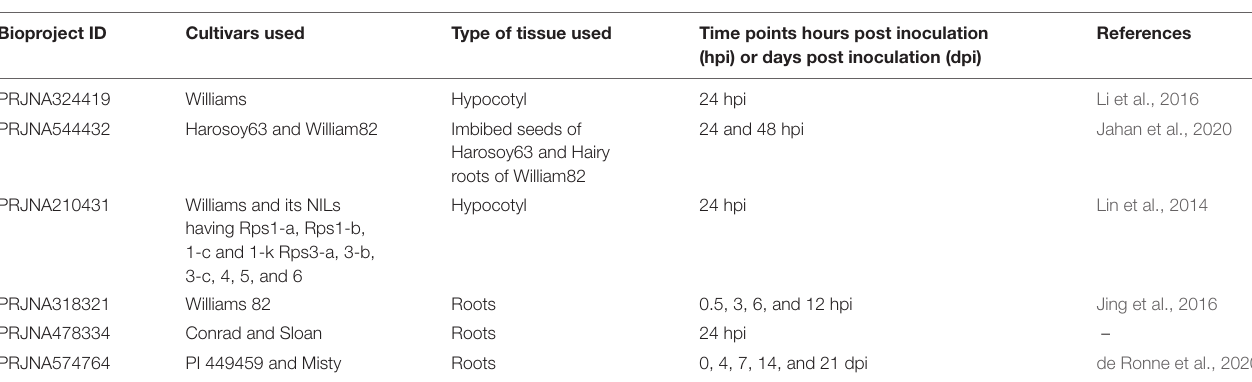
TABLE 5 | List of high throughput transcriptome bioprojects used in the